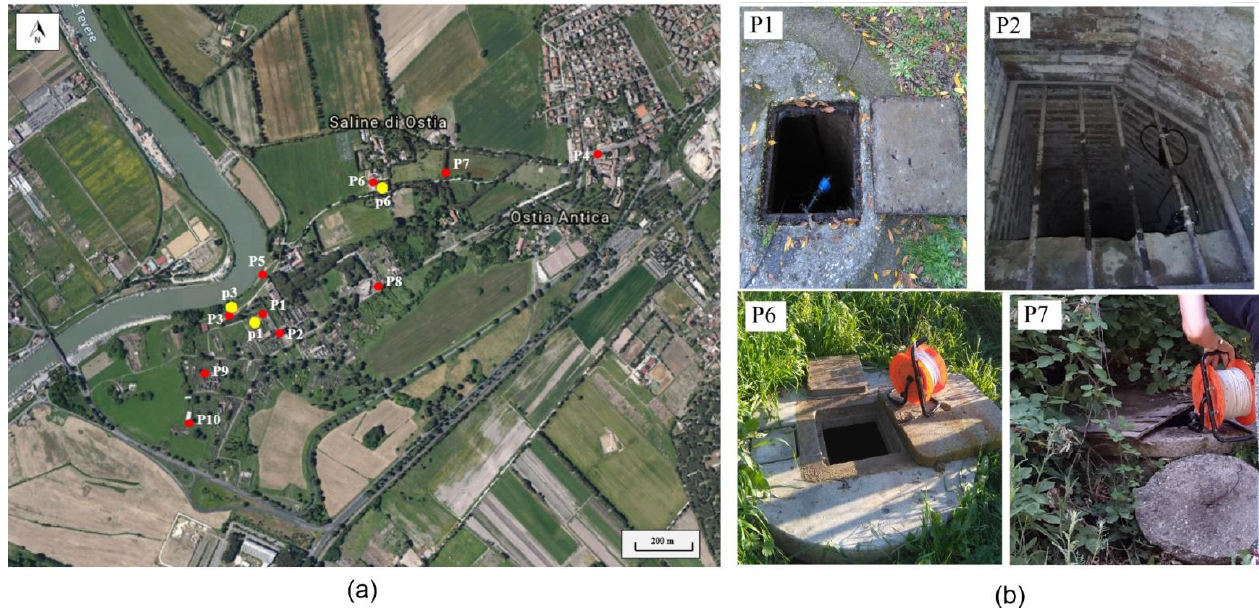
Figure 3. ( a ) Location of sampling wells (red points) and drillings (yellow points). ( b ) Some monitored wells: P1, P2, P6, and P7. For geographic coordinates in Figure 3a, the reader is referred to Figures 1 and 2.